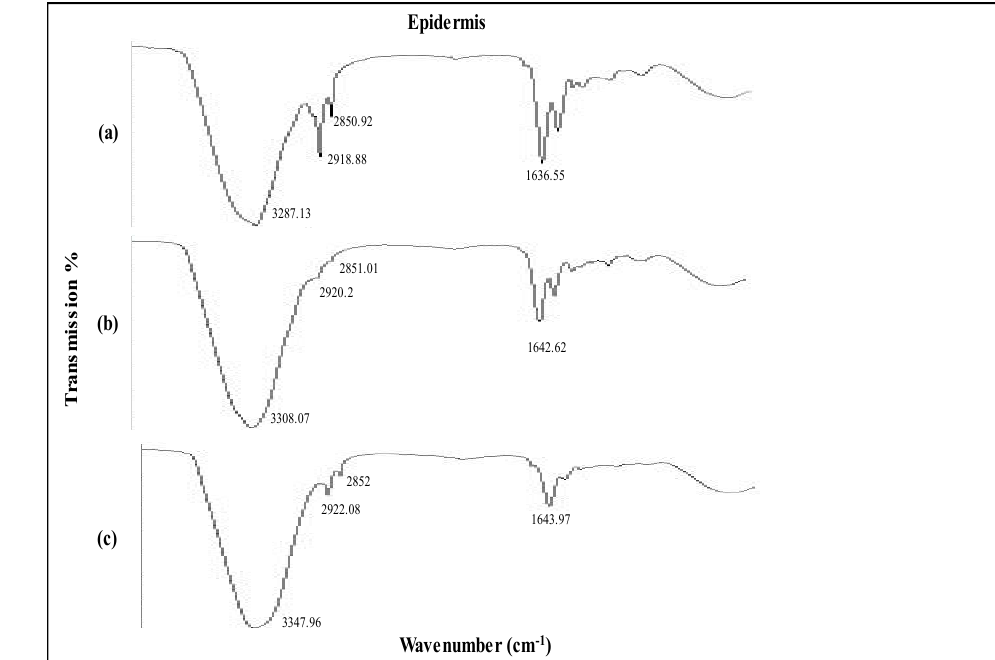
Figure 6. IR spectroscopy images of epidermis ( a ) untreated skin and skin loaded with ( b ) MTX plain gel and ( c ) MTX NEG.